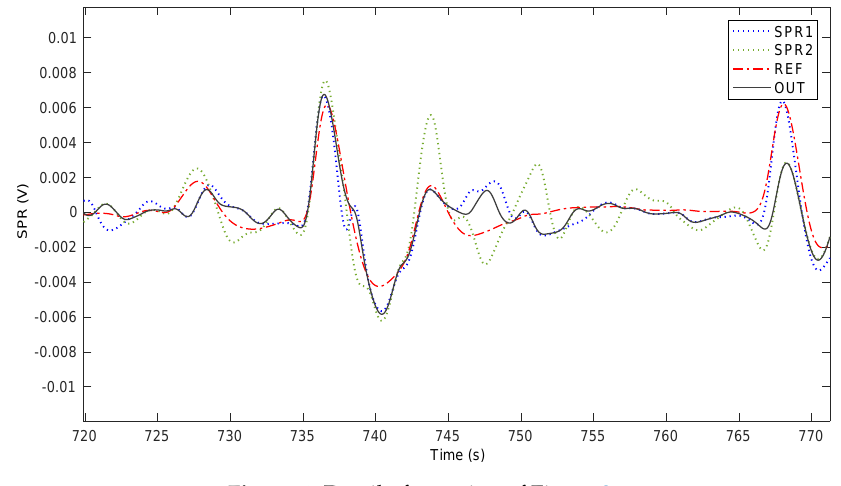
Figure 4. Detail of a section of Figure